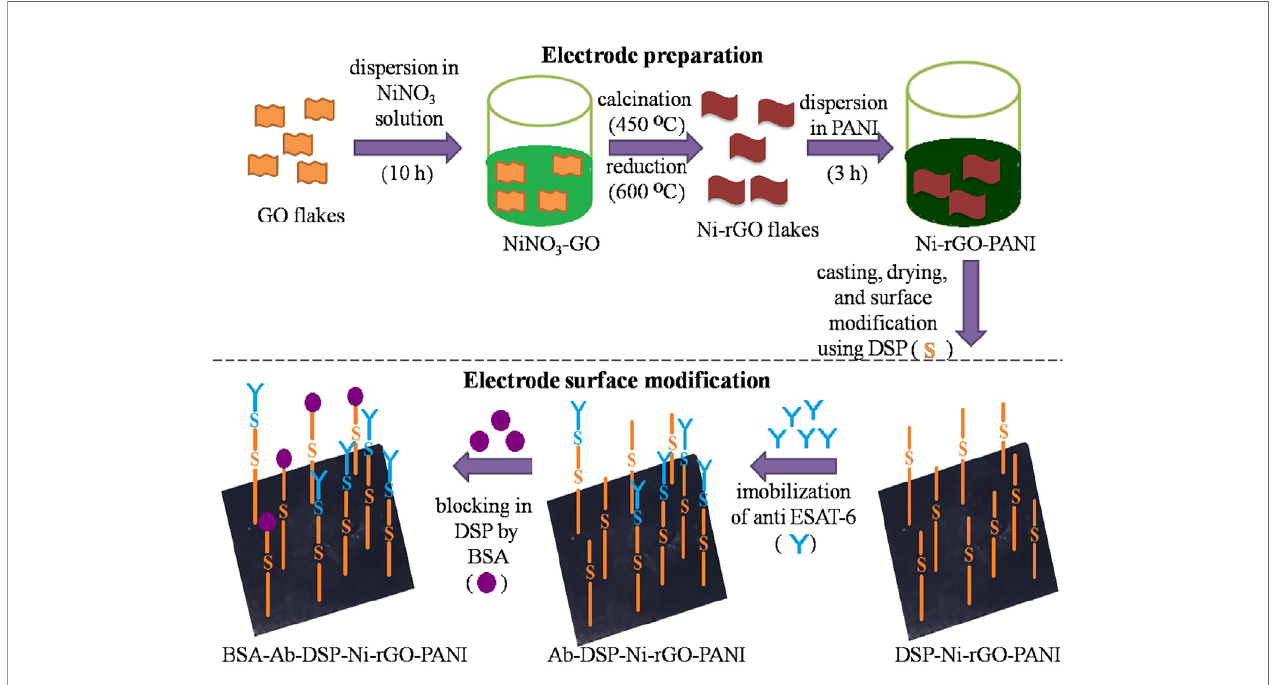
FIGURE 1 | Electrode preparation and surface modi fi